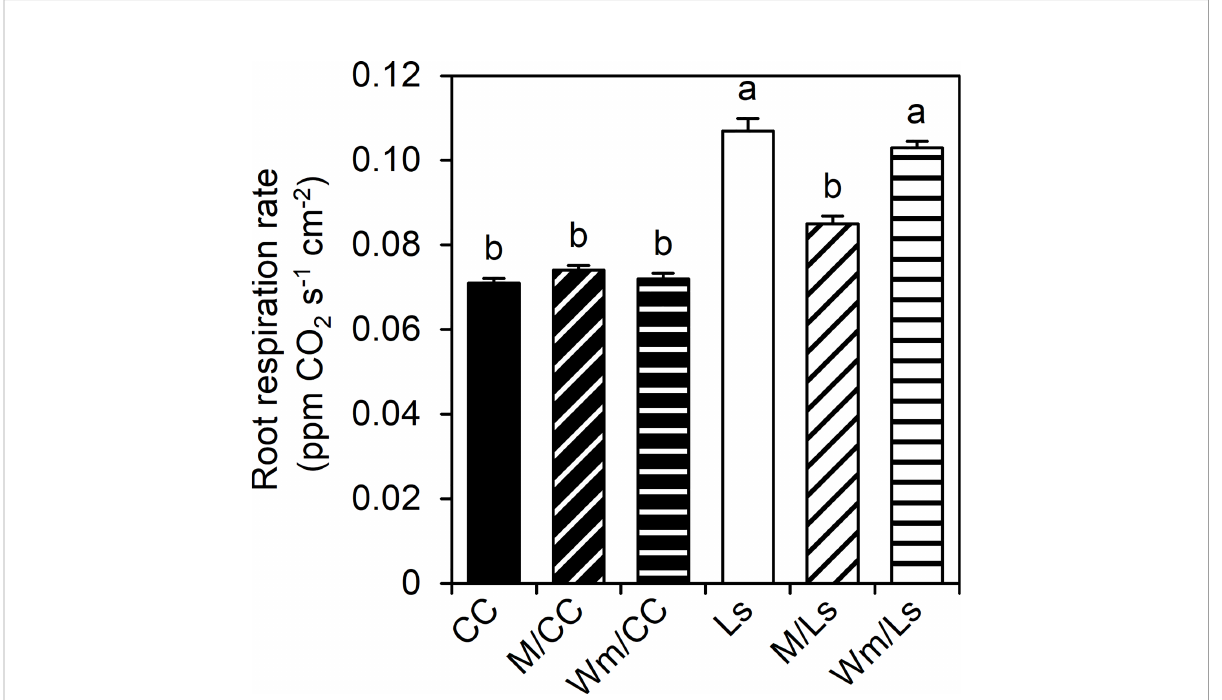
FIGURE 3 Root respiration rate per surface area (RRR, ppm CO 2 s − 1 cm − 2 ) of self-grafted Lagenaria siceraria (Ls) and Cucurbita maxima × Cucurbita moschata (CC), and of respective heterografts with melon (M) and watermelon (Wm) at day 60 after grafting (DAG 60). Different letters indicate signi fi cant differences between RRR (Tukey test, p < 0.05; mean ±